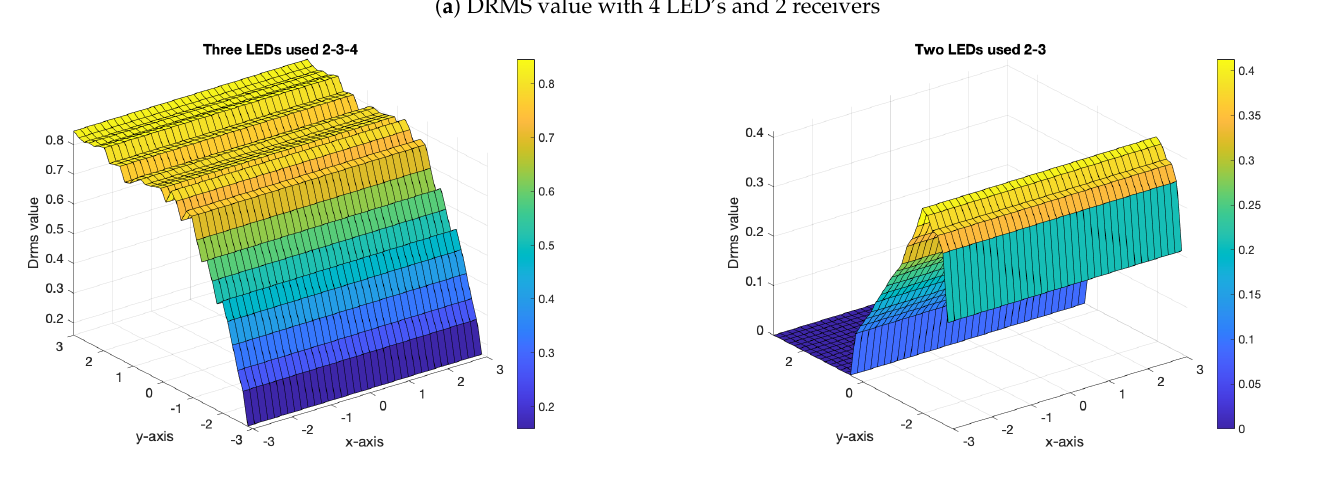
Figure 8. DRMS delay at a different number of